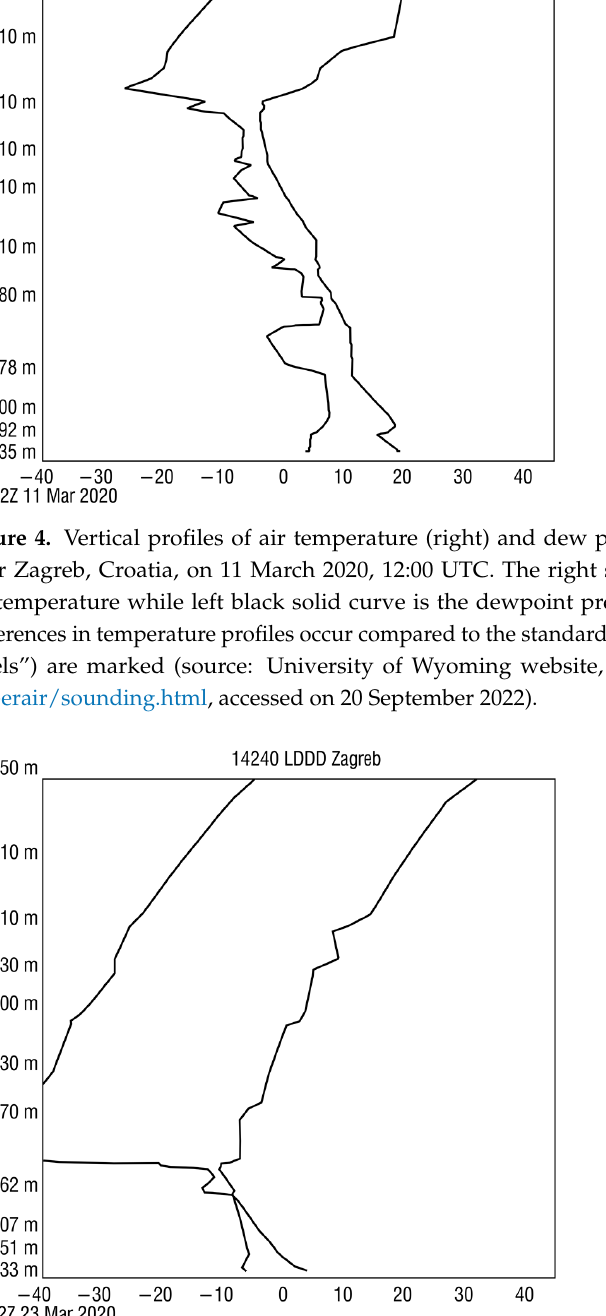
Figure 5. Vertical profiles of air temperature (right) and dew point (left) based on probing data over Zagreb, Croatia, on 23 March 2020, 12:00 UTC. The right solid black curve is profile of the air temperature while left black solid curve is the dewpoint profile, heights at which significant differences in temperature profiles occur compared to the standard atmosphere (so-called “significant levels”) are marked (source: University of Wyoming website, URL http://weather.uwyo.edu/up- perair/sounding.html, accessed on 20 September 2022).